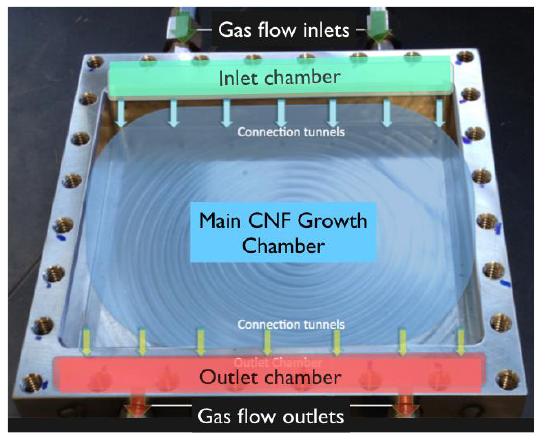
Figure 1. The mold design included inlet and outlet connections, rectangular inlet and outlet chambers (where gases spread out), and connection tunnels from those to the main growth chamber. The mold had a lid that hermetically sealed the growth chamber.